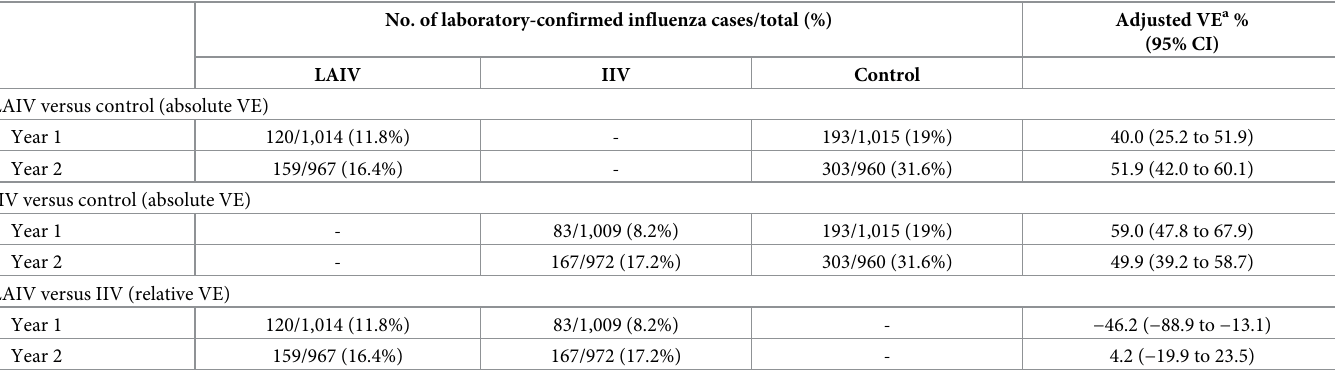
Table 2. Absolute and relative VE of live attenuated and inactivated influenza vaccines in preventing laboratory-confirmed influenza illness, by study year. No. of laboratory-confirmed influenza cases/total